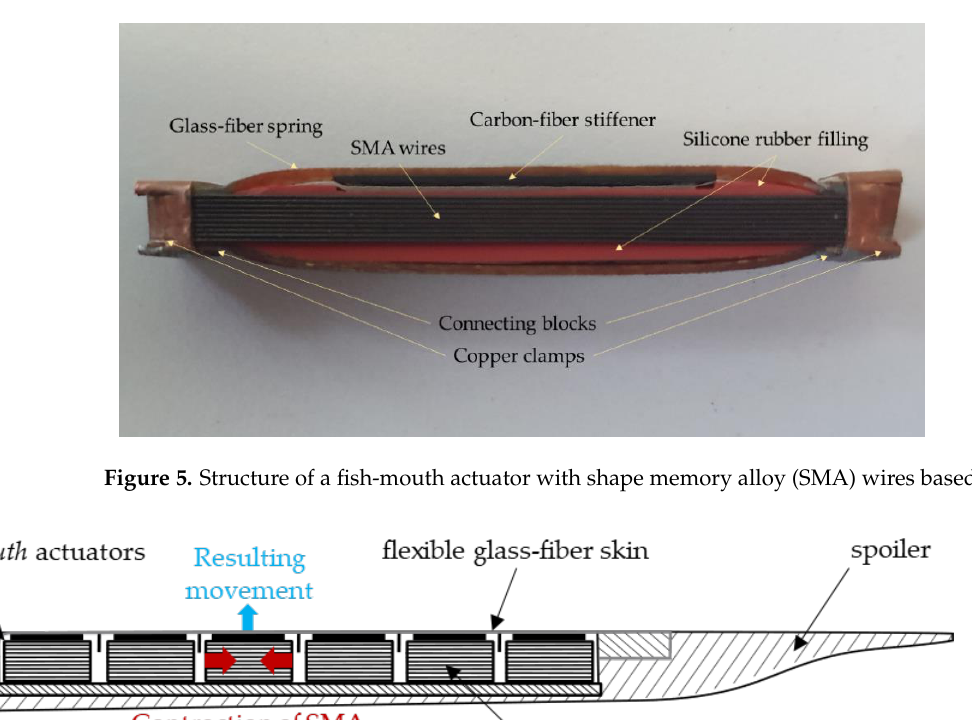
Figure 5. Structure of a fish-mouth actuator with shape memory alloy (SMA) wires based on [71,72].